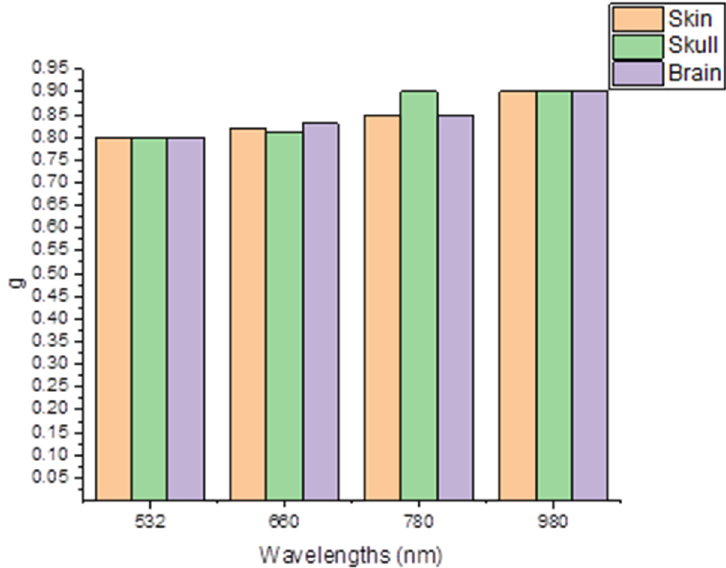
Figure 11. Anisotropy factor ( g ) measured for all of the tissue types. The proportion of the contrast factor in Figure 11 differs slightly in the scalp compared with in the skull, as well as the brain for the rabbit head, as well as with the different wavelengths used in our experiment. Therefore, little variation was noted between them, while in Figure 12 which compared our data with data from the literature, there was a difference between this and the variance factor measured for [36] in contrast with [29], which was closer to our measurements.